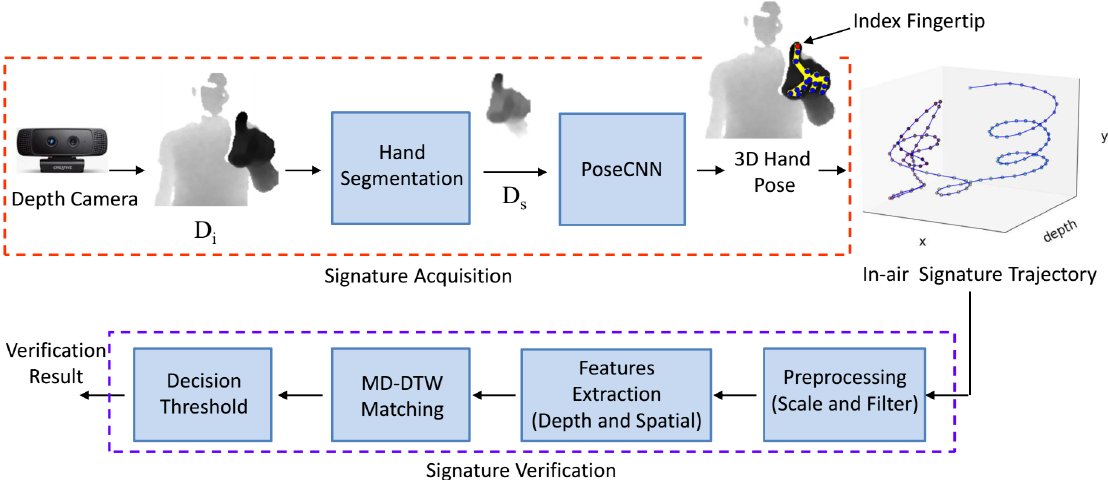
Figure 1. An overview of our method for in-air signature acquisition and verification. In the acquisition phase, the hand region is first segmented from a raw depth frame. Then, the estimated 3D position of the index fingertip is recorded for every frame using a CNN-based hand pose estimation method. For verification, the test signature is scaled and filtered. Thereafter, the spatial and depth features are extracted for matching using the MD-DTW algorithm. Finally, the test signature is verified by the decision threshold.